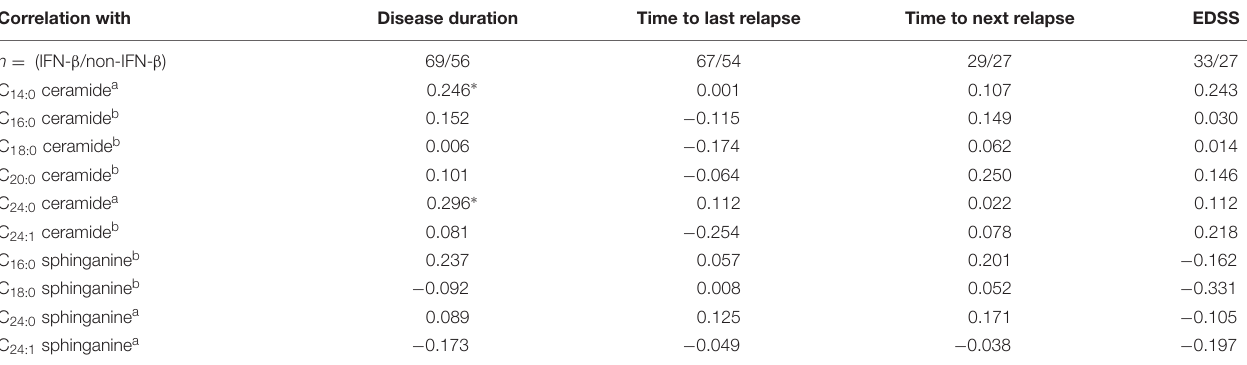
FIGURE 2 | S1P and dhS1P level are affected by the respective treatment regime. (A–D) Sphinganines were determined from plasma of RRMS patients and healthy controls, as well as (E,F) S1P and dhS1P. Data shown are Tukey box plots with a horizontal line representing the median, whiskers representing the 1.5 × interquartile range and dots representing outliers. Healthy controls ( n = 21), untreated patients (w/o, n = 11), IFN- β ( n = 18), natalizumab ( n = 16), and fingolimod ( n = 24) treated patients. One-Way ANOVA with Tukey’s post hoc comparison test or Kruskal-Wallis’ test with Dunn’s post hoc comparison for normally or non-normally distributed data, respectively. ∗ p ≤ 0.05; ∗∗ p < 0.01. TABLE 4 | Plasma sphingosines and ceramides are not affected by RRMS, independent from the treatment. Correlation with Disease duration Time to last relapse Time to next